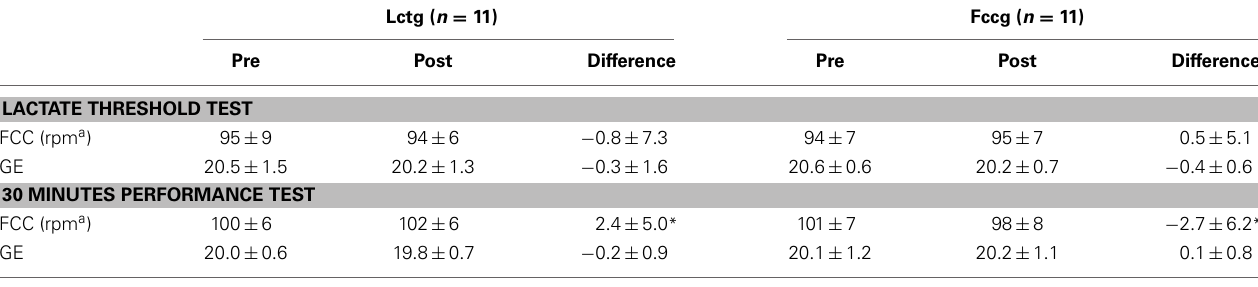
Table 3 | Freely chosen cadence (FCC) and gross efficiency (GE) (mean ± SD ) during the lactate threshold test and during the 30min performance test pre and post training intervention period for the low cadence training group (Lctg) and the freely chosen cadence group (Fccg).